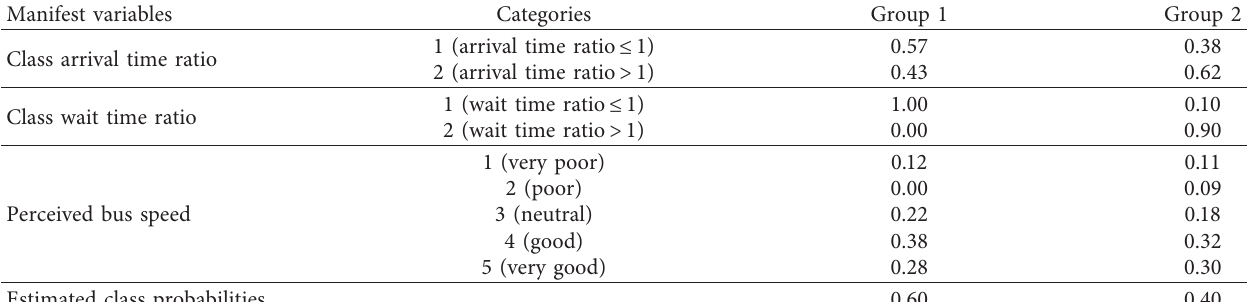
Table 1: Estimated conditional and class probabilities with two latent